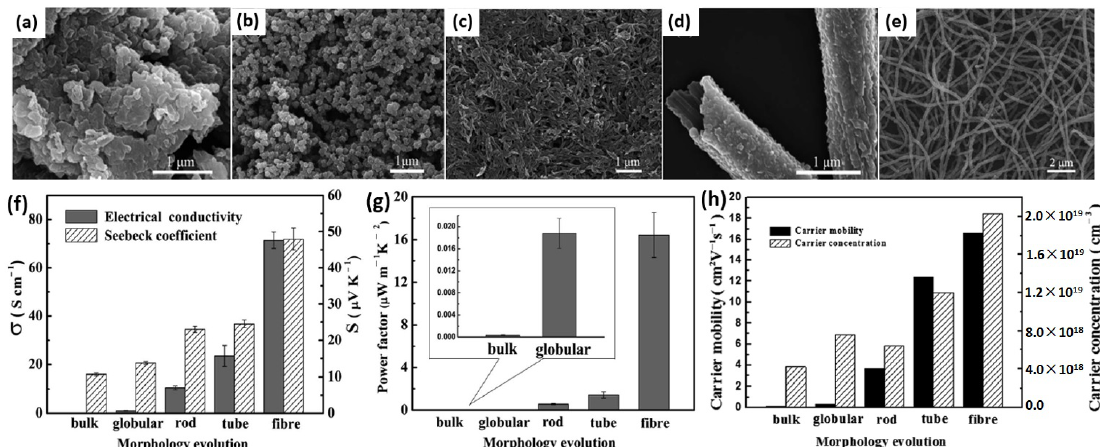
Figure 3. SEM images of ( a ) bulk PEDOT power; ( b ) globular nanoparticles; ( c ) nanorods or ellipsoidal nanoparticles; ( d ) nanotubes; ( e ) nanofibers; ( f ) Seebeck coefficient and ( g ) power factor of bulk PEDOT and PEDOT nanostructures; ( h ) Carrier mobilities and carrier concentrations of bulk PEDOT and PEDOT nanostructures. Readapted with permission from The Royal Society of Chemistry